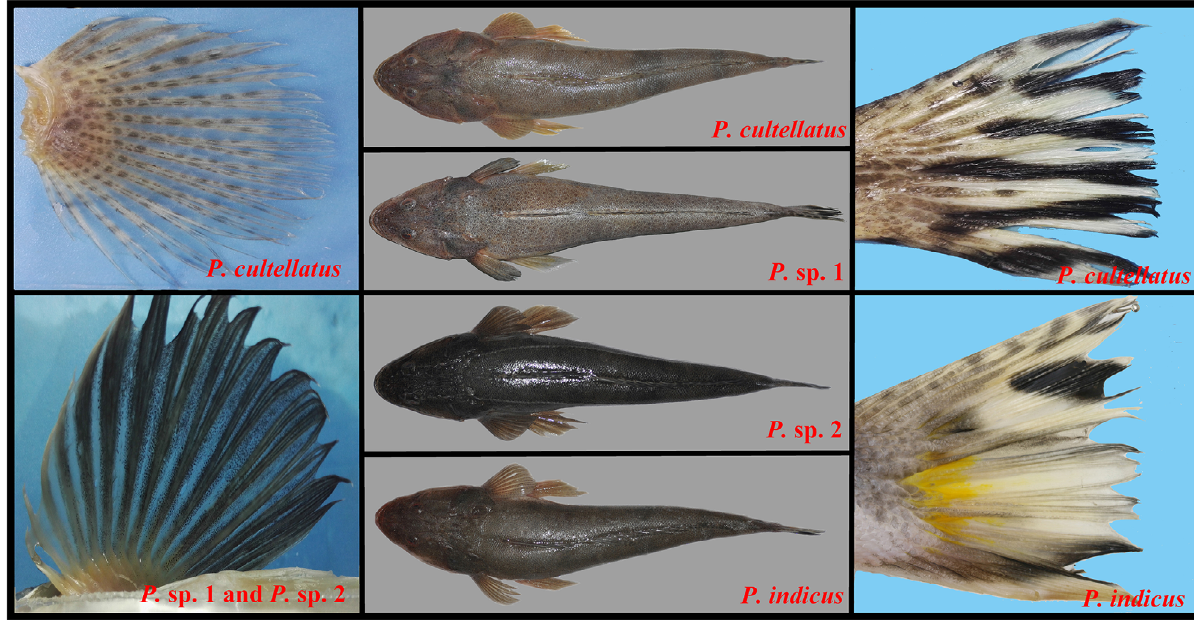
Fig. 4. Distinguishing characteristic among four species distributed in northwest Paci fi c